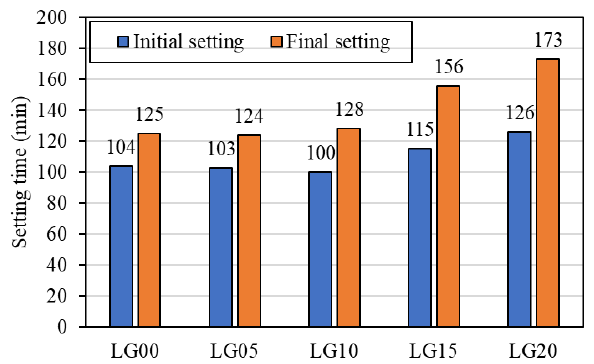
Figure 6. Setting time of geopolymer mortar containing BLWA.